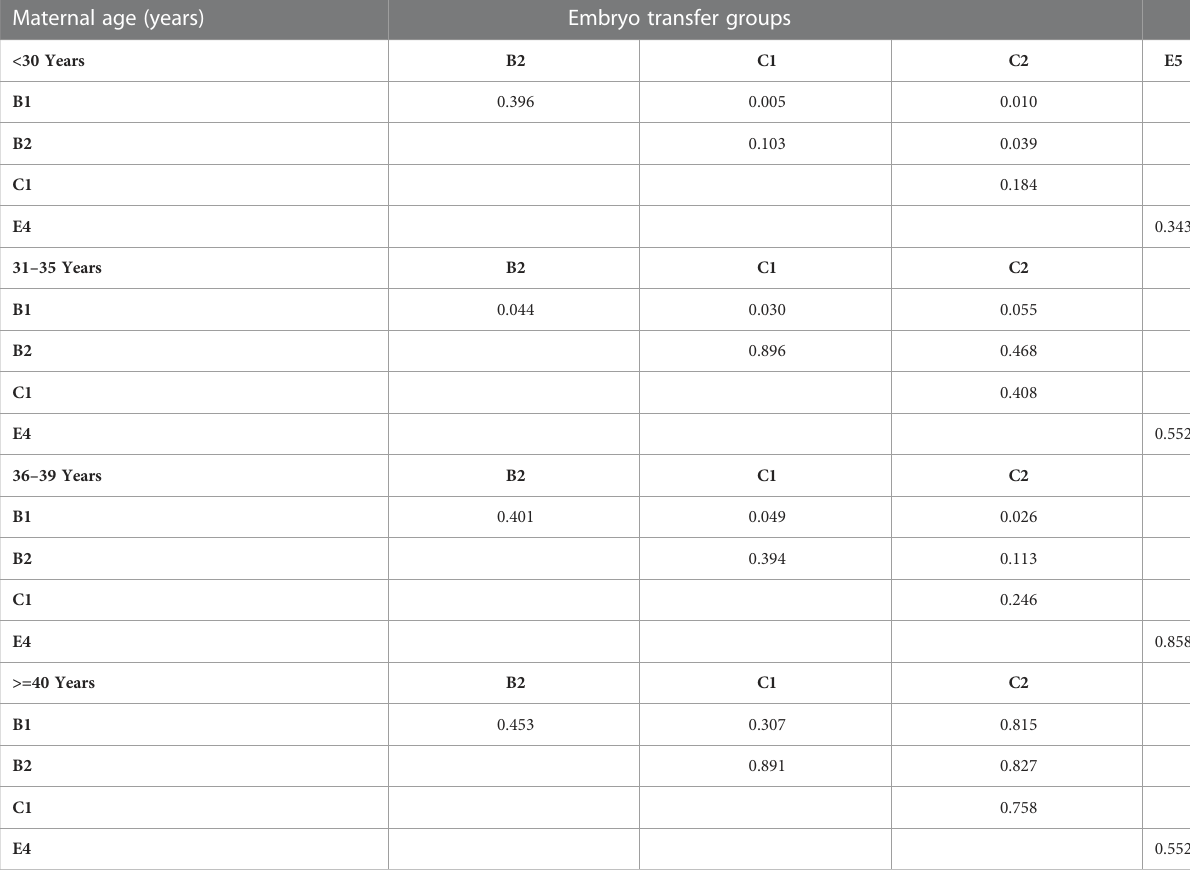
TABLE 8 Multiple comparison of multiple birth rate for embryo transfer groups based on maternal age. Maternal age